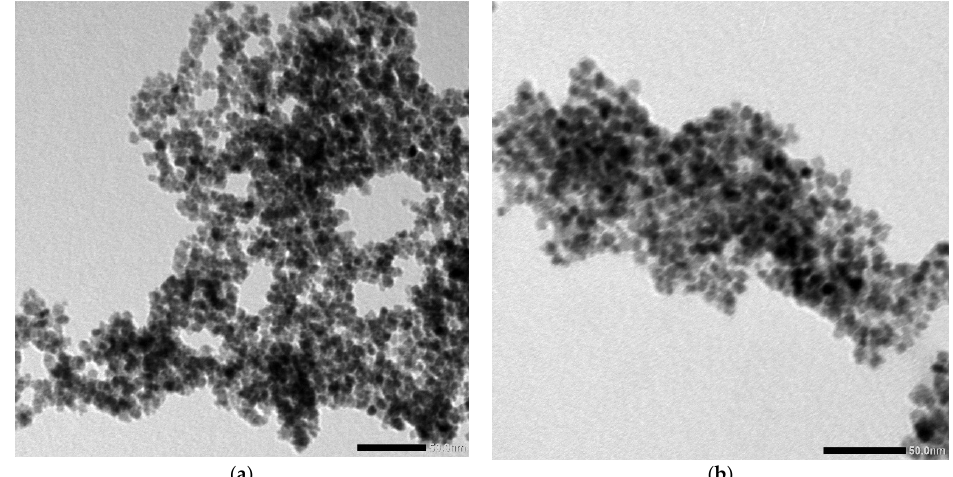
Figure 2. TEM image of ( a ) ceria nanoparticles and ( b ) gold–ceria nanoparticles. Now, the fluorescence emission of gold-ceria nanoparticles is shown through added DO at different concentrations, as shown in Figure 3. The fluorescence intensity was quenched due to the increased DO concentration. This quenching is due to the adsorption of dissolved oxygen within the formed oxygen vacancies inside the crystalline structure of the ceria nanoparticles. To detect the mechanism of quenching, the absorbance dispersion was measured for gold–ceria nanoparticles at different added DO concentrations, as shown in Figure 4a. Then, the corresponding bandgap of ceria nanoparticles was calculated through the following equation [23] α (cid:1831) =A( (cid:1831) − (cid:1831) (cid:1859) ) 1/2 (1) where α is the optical absorbance, A is a material-dependent constant related to effective masses of electrons and holes, E is the absorbed photon energy, and Eg is the allowed direct bandgap. From both Figure 4a,b, the blue-shift in both absorbance and bandgap is observed due to an incremental concentration of added dissolved oxygen. This proves the dominant static adsorption nature of gold- ceria NPs to dissolved oxygen due to the increased formation of charged oxygen vacancies associated with the more formed tri-valent cerium ions.